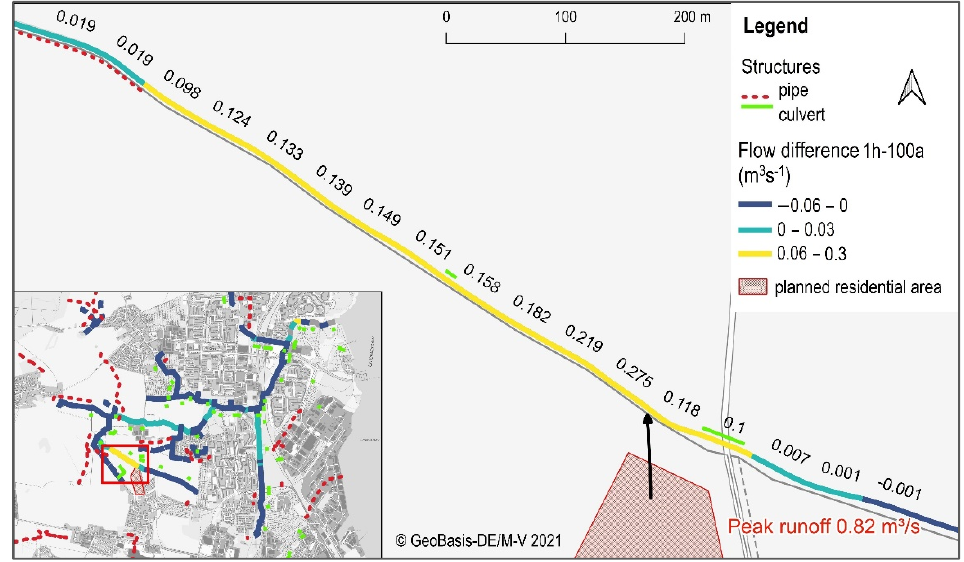
Figure 9. Flow difference (m 3 s − 1 ) in the immediate area of the discharge point for the rain event 1h- 100a simulated with SWMM.